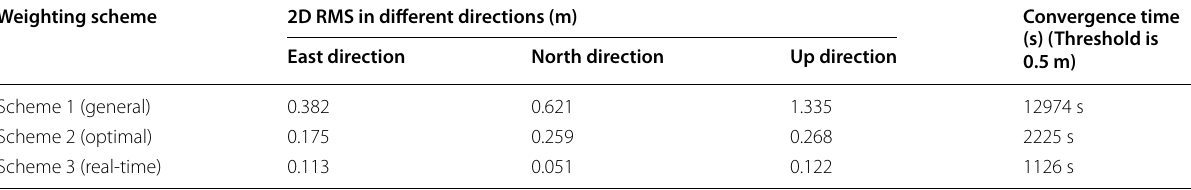
Table 5 Statistical results of PPP positioning errors and convergence time based on ship-borne dynamic test data Weighting scheme 2D RMS in different directions